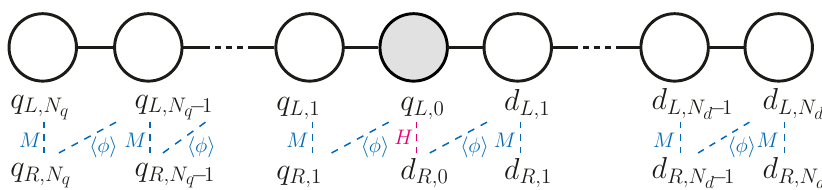
Figure 2 . The anomaly free inverted Froggatt-Nielsen model for a single generation of down quarks. The quark doublet vector-like chain is to the left, and down quark singlet vector-like chain to the right of the central node, shaded with gray. The horizontal charges of (cid:12)elds on each node di(cid:11)er by 1. The central node has chiral quark (cid:12)elds, uncharged under the horizontal U(1) FN , coupling to the Higgs. For clarity of presentation the labels on vector-like masses, as well as the Yukawa couplings are not